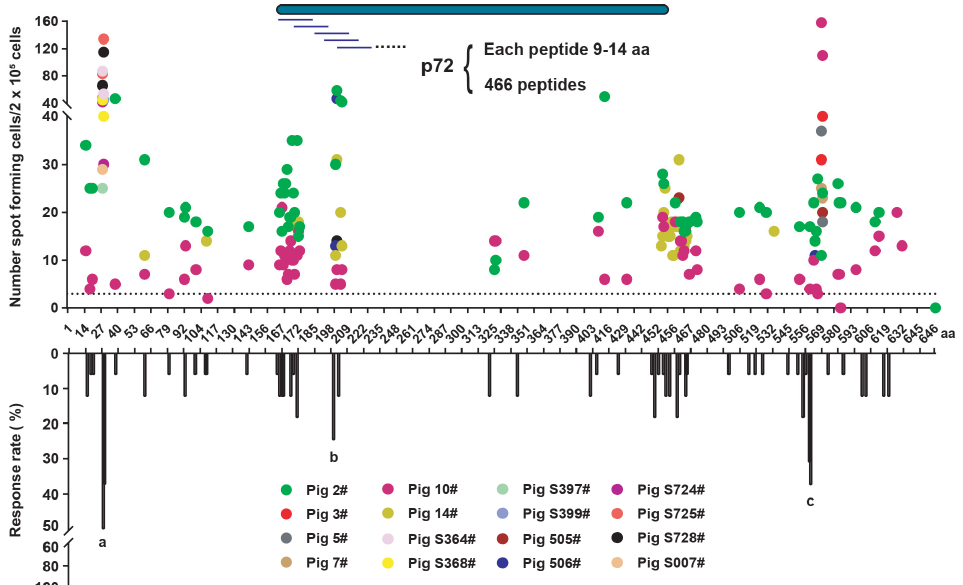
Figure 2. Prediction of p72 porcine leukocyte antigen (SLA) class I-restricted T cell epitopes and screening of positive epitopes. The p72 protein (full length of 646 aa) contains 466 possible peptides, each about 9–14 aa (Supplementary data). The screening of positive epitopes through the peptide library for stimulation of the PBMCs of surviving pigs (n = 16) by ELISPOT assay. Response rates of various peptides in surviving pigs (n = 16). ( a ) Peptide 351 (P351); ( b ) peptide 334 (P334); and ( c ), peptide 366 (P366).